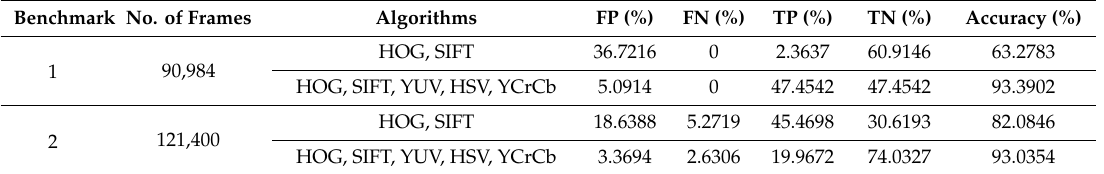
Table 1. Benchmark results using the combined methods of HOG, SIFT, color spaces YUV, HSV and YCrCb.